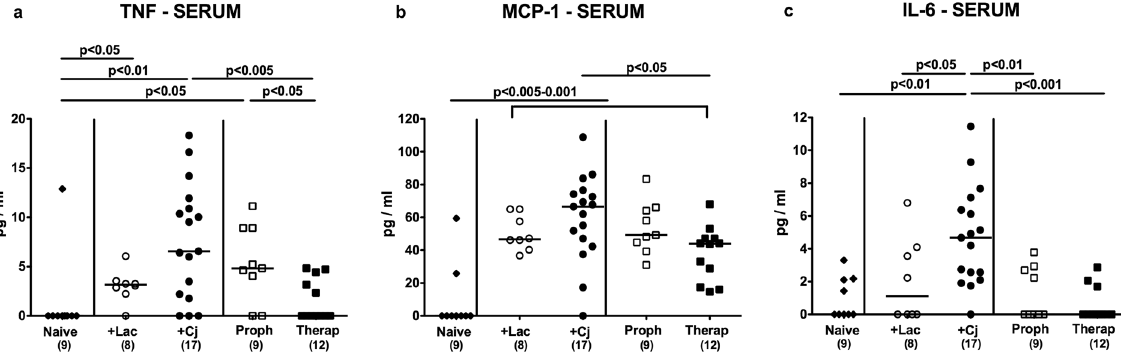
Figure 8. Pro-inflammatory cytokine secretion in serum of C . jejuni strain 81–176 and/or L . johnsonii reassociated secondary abiotic mice. Secondary abiotic mice were perorally infected with C . jejuni strain 81–176 (Cj) and associated with L . johnsonii (Lac) either 14 days before (prophylactic regimen, Proph; white squares) or 7 days thereafter (therapeutic regimen, Therap; black squares) and compared to mono-associated mice ( + Lac, white circles; + Cj, black circles). ( a ) TNF, ( b ) MCP-1 and ( c ) IL-6 concentrations were determined in serum samples at days 21 or 28 following initial C . jejuni or L . johnsonii infection, respectively. Naive (N) mice (black diamonds) served as uninfected controls. Medians (black bars), levels of significance (p-value)